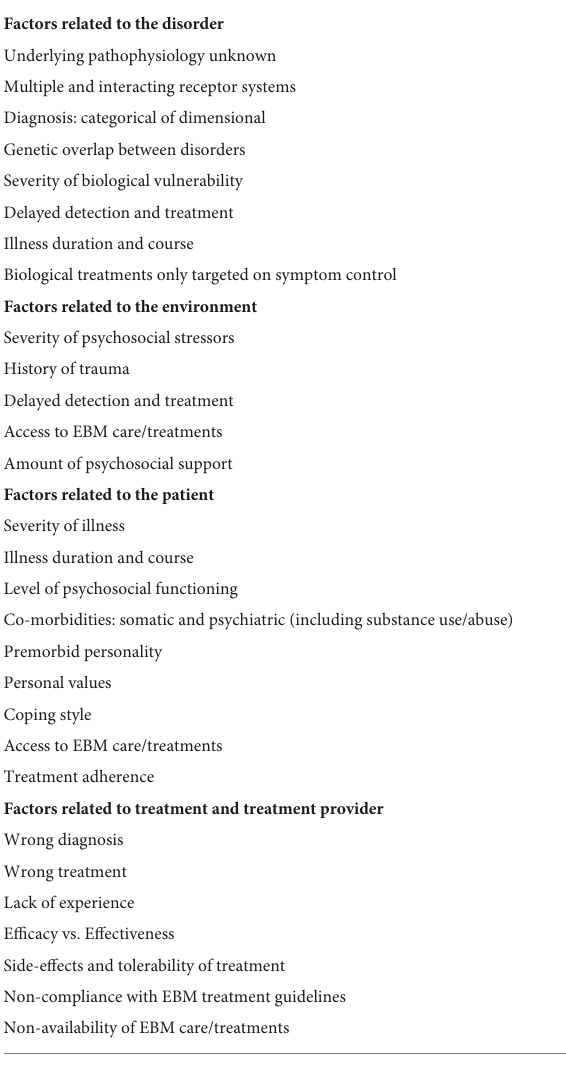
TABLE 1 Potential reasons for poor response and treatment-resistance (adapted from 4). Reasons for poor response to treatment and treatment